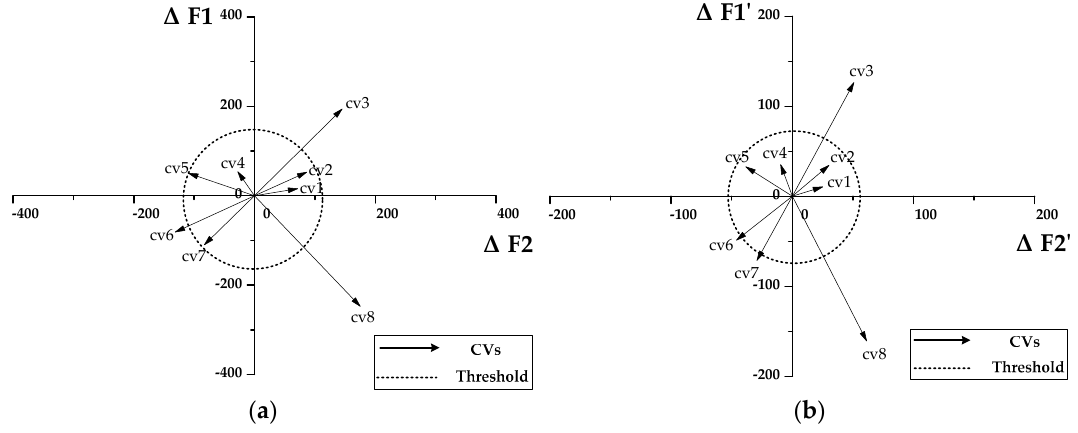
Figure 1. The comparison of standard CVA and SAW-CVA in Cartesian coordinate system. ( a ) Representation of Standard CVA; ( b ) Representation of SAW-CVA.